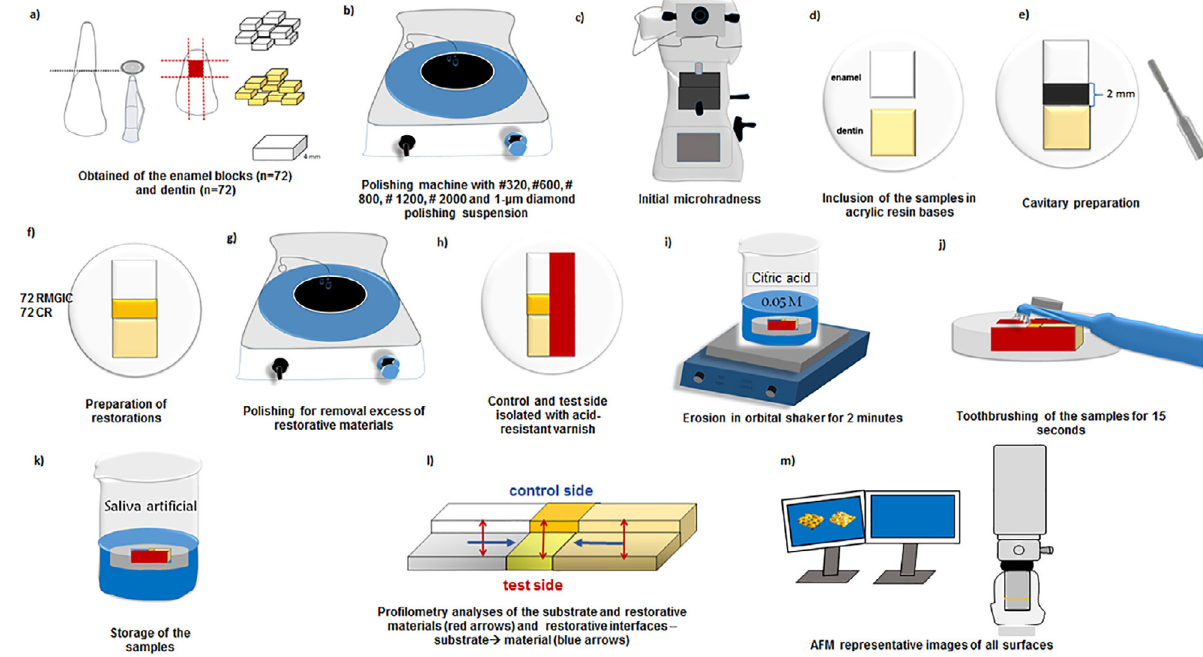
Figure 1- Study flowchart. a,b) Sequence of collection and polishing of enamel and dentin blocks (4×4 mm2). c) Blocks Initial selection by determining microhardness. d) Blocks inclusion, using a metallic matrix e) Cavitary preparation using diamond tip (#1149) f) Restoration with selected restorative material. g) Material excess removal with sandpaper (#1200) h) Application of acid-resistant varnish to create a control side for each specimen. i, j, k) Samples subjected to 5-day erosion and abrasion cycles and storage in remineralizing solution.